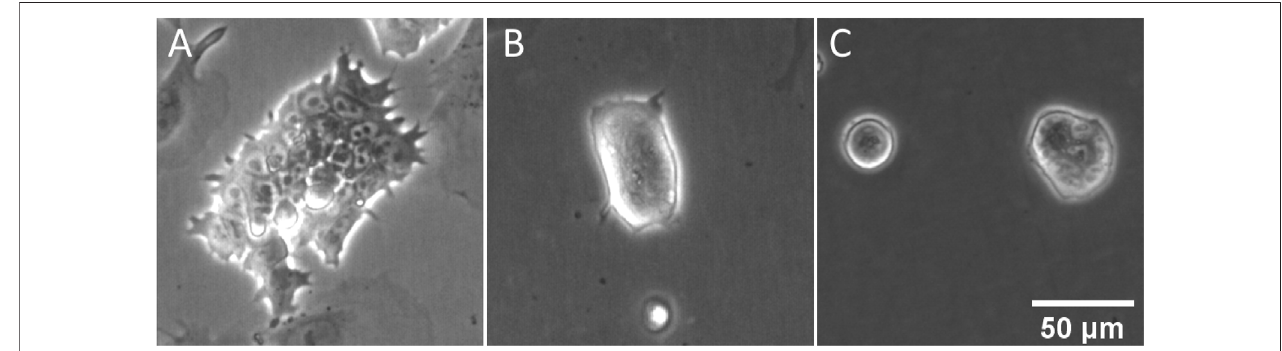
FIGURE 1 | Morphological heterogeneity in ESC colonies maintained with LIF and FBS. Phase contrast images were collected during routine culture of E14TG2a ESCs in both LIF/FBS medium (A,B) and 2i/KSR medium (C) . In the LIF medium, some colonies can be seen to adopt a compact morphology (A) , while other colonies adopt a fl attened, pseudo-epithelial morphology (B) . In 2i/KSR, cells grow as compact, almost spherical colonies (C) .